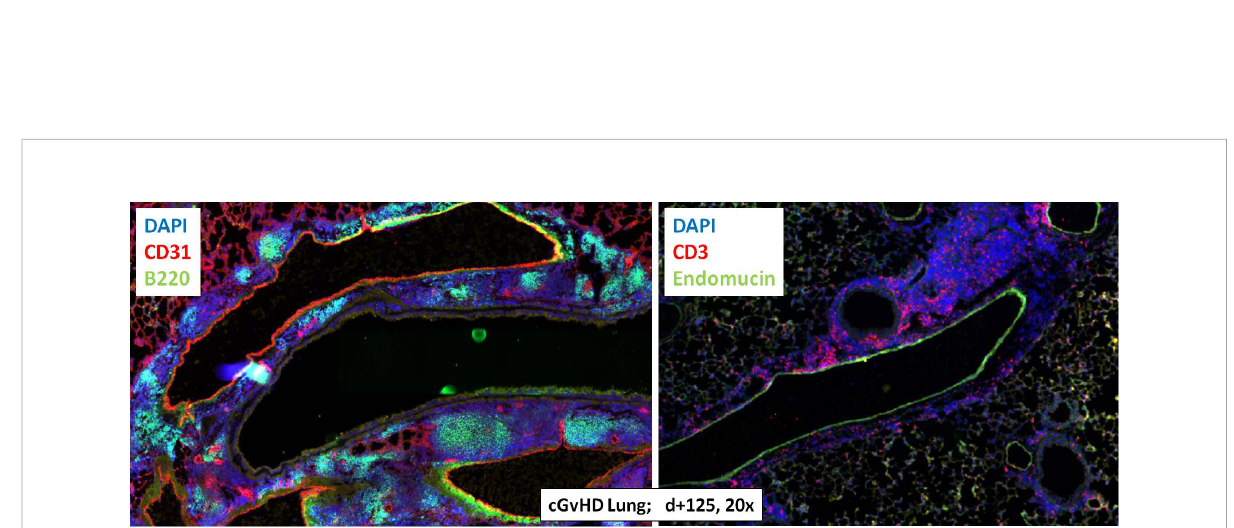
FIGURE 6 Tissue immune cell in fi ltration in lungs from C57BL/6 ➔ BDF1 during established cGvHD. Representative immunohisto fl uorescence images of cGvHD lungs at day +125 showed massive immune cell in fi ltrates (indicated by DAPI staining, blue) with dense foci of B220+ B cells (left, green) and CD3+ T cells (right, red). Magni fi cation